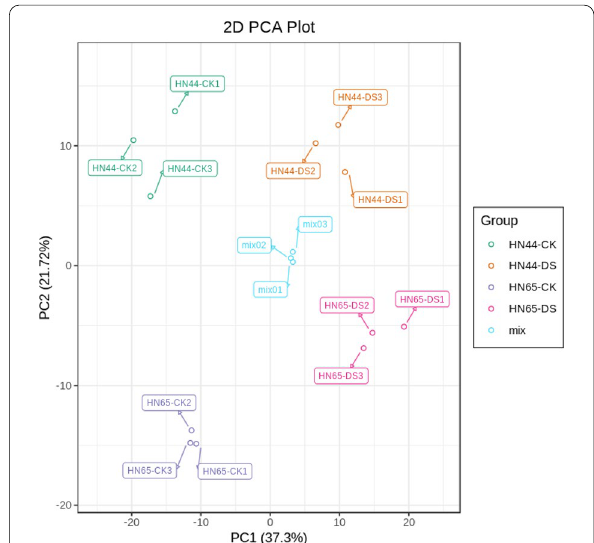
Fig. 3 PCA score chart. The X-axis represents the first principal component and the Y-axis represents the second principal component. The closer the distance between the samples, the better the repeatability